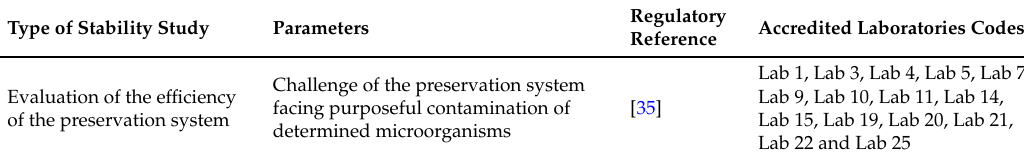
Table 7. Accredited laboratories for the stability evaluation of cosmetics: “challenge test”.